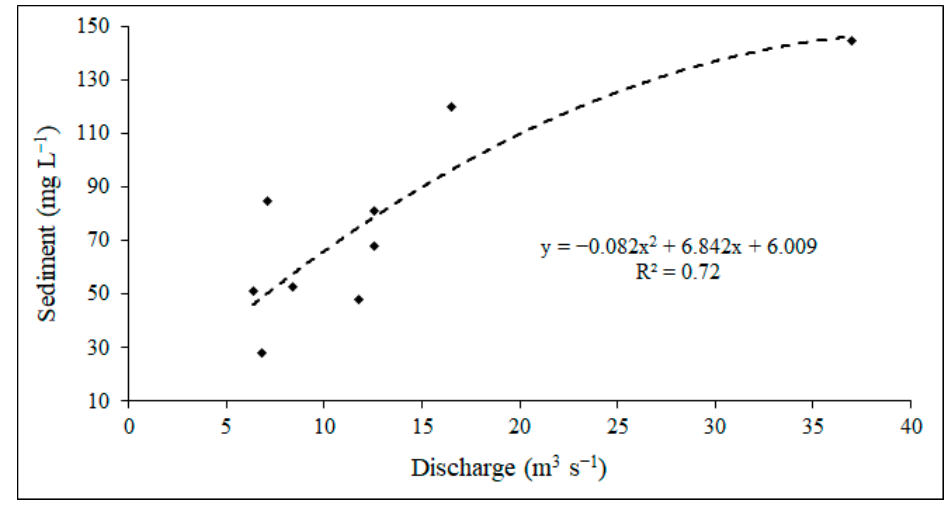
Figure 3. Water discharge curve (sediment transported × water discharge) in the Jaguari River Hydrographic Subbasin, Brazil.